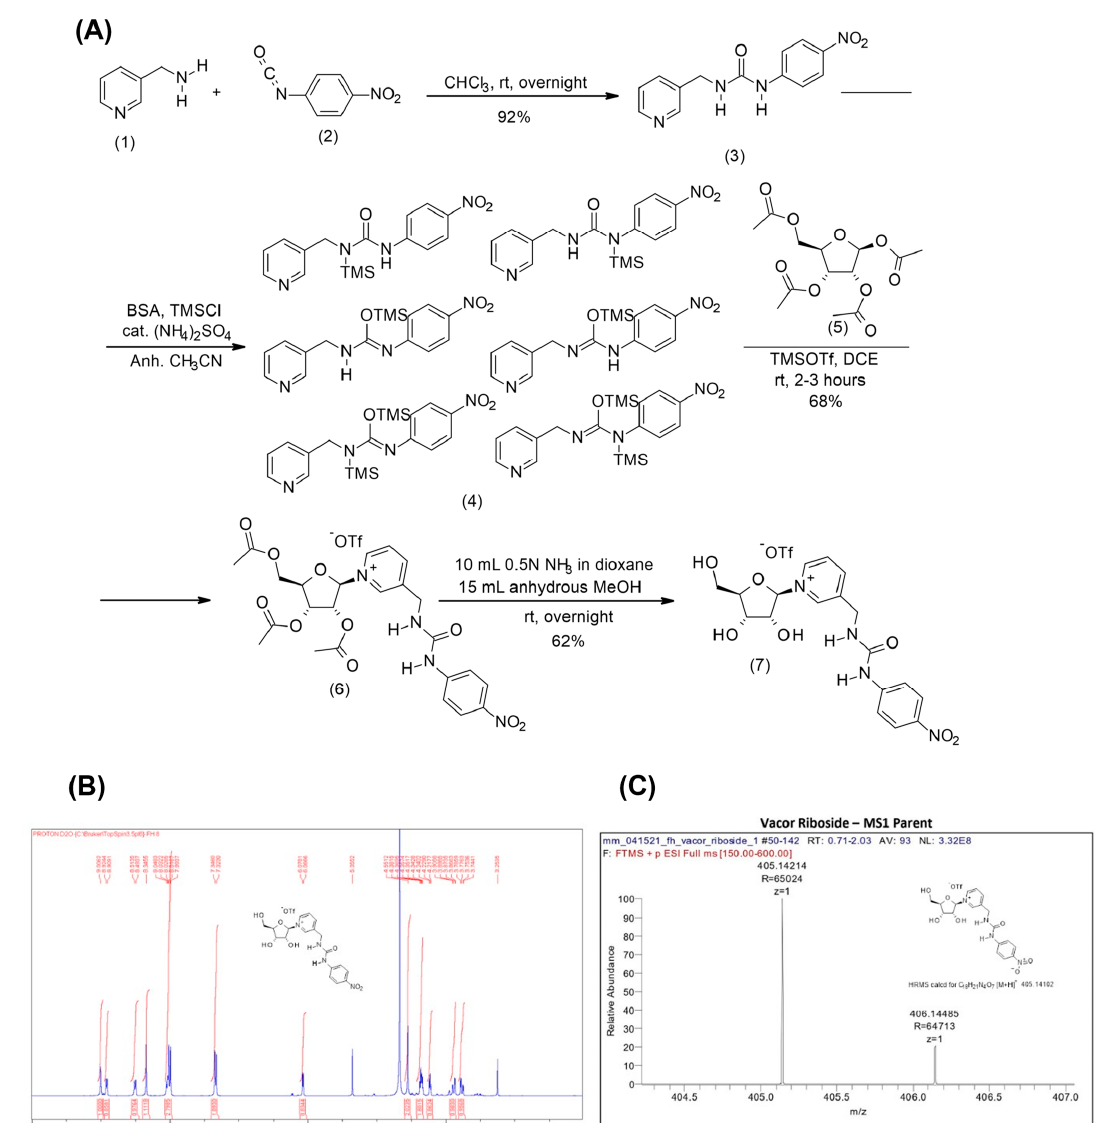
Figure 3. Chemical synthesis of VR. ( A ) Scheme of the synthesis of VR from vacor via Vorbruggen chemistry. ( B ) NMR spectrum of the synthesized VR. ( C ) Mass spectrum of VR.